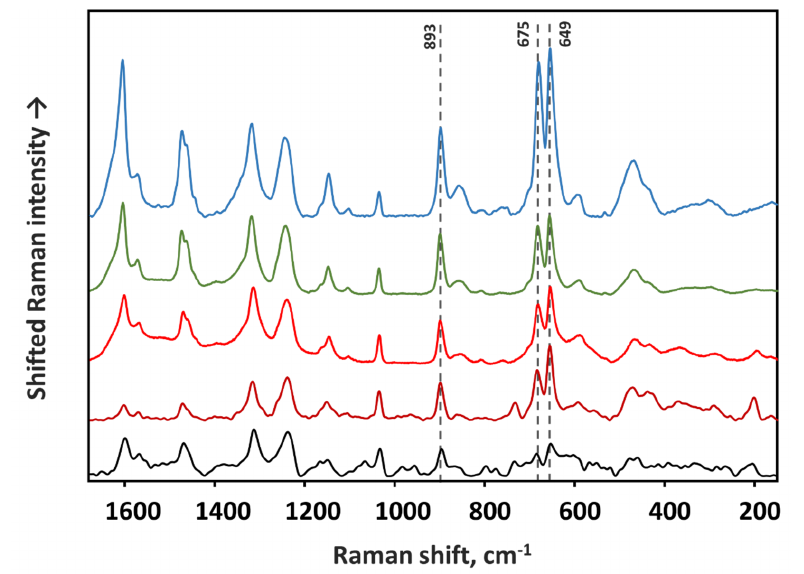
Figure 7. Raman spectra of salicylic acid–MXene complex with different excitations. Excitations from top to bottom: 457 nm; 532 nm; 633 nm; 785 nm; 1064 nm. Based on the spectra acquired at different excitations, the enhancement factor de- pendence on the excitation can be evaluated (Figure 8). To minimize the influence of spec- trometer response to different wavelength, the crystalline salicylic acid was acquired with each excitation, and the salicylic acid–MXene complex spectrum was compared to crys- talline salicylic acid spectrum acquired at the same conditions. Indeed, the SERS enhancement factor for out-of-plane vibrations is as expected for the chemical enhancement mechanism. The enhancement factor for the substrate covered by the salicylic acid–MXene complex was calculated for the most enhanced vibrational band at 654 cm − 1 (carboxyl deformation + out-of-plane C-C bending). As the enhancement factor value dependency on the excitation wavelength indicates, the highest enhancement of 220 is achieved with a 532 nm laser (Figure 8). Nevertheless, 457 nm and 633 nm exci- tations also yield comparable enhancement of 165 and 178, respectively. The 785 nm exci- tation fell into the absorption of MXenes; for this reason, the Raman spectral bands of MXene phonon modes are still observable in the spectrum, and the enhancement factor reaches 150. For the excitation profile of 1064 nm, an entirely different Fourier Transform- Raman spectrometer was used. It was observed that MXene film without salicylic acid highly absorbs this wavelength, generates heat and makes the registration of spectrum with this excitation impossible. Nevertheless, when the salicylic acid–MXene complex is excited, the characteristic spectrum is observed, which is indicating changes in the elec- tron distribution of the MXene layer. It is worth mentioning that based on our results, the chemical mechanism of enhance- ment takes place between salicylic acid and MXenes. The observable hot spot effect of SERS substrates arises when the intensity crucially depends on the different spots of the